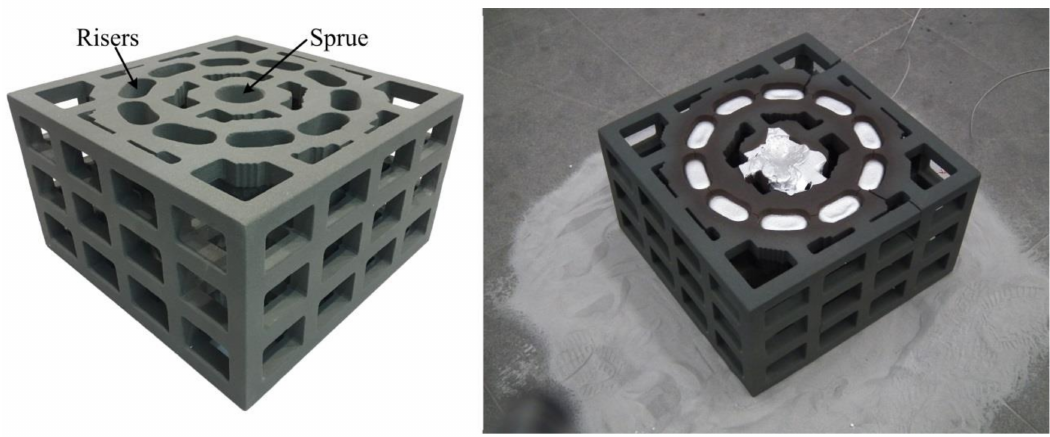
Figure 9. The 3D-printed lattice shell sand mold and onsite pouring experiment.